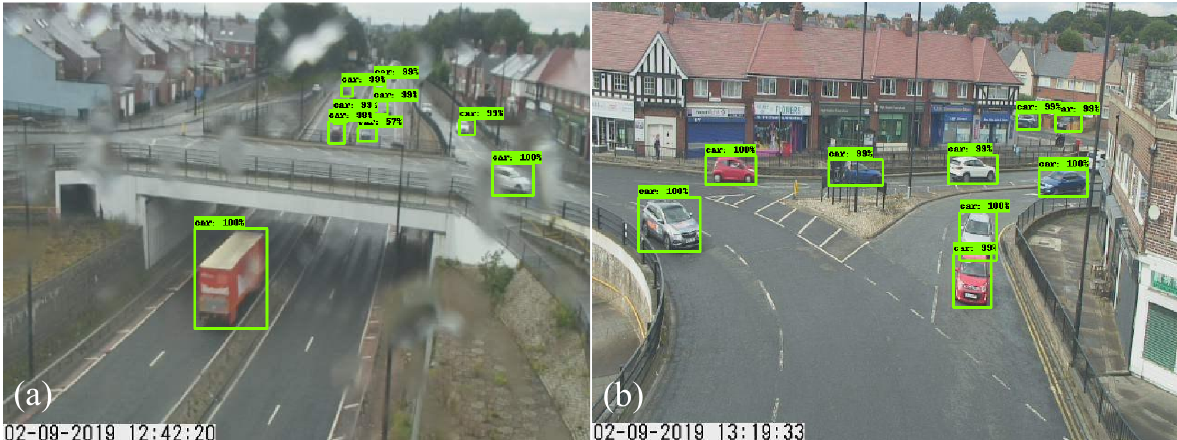
Figure 2. Detected vehicles on 2 August 2019 in two out of four views of the NC_A1058C1 CCTV. ( a ) View towards a main road; ( b ) View towards a residential